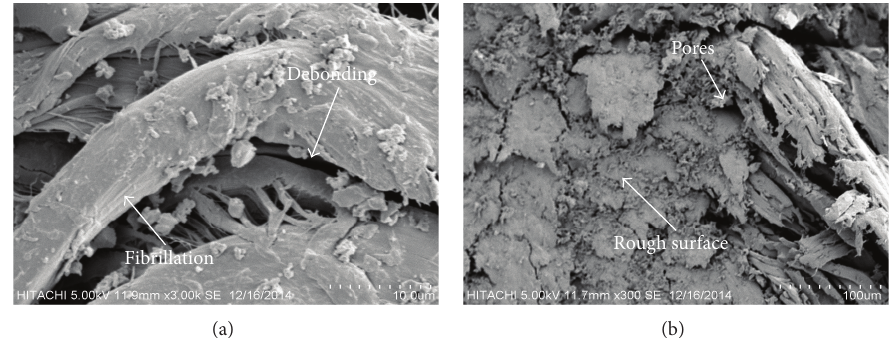
Figure 11: (a) The SEM micrographs of the tensile failure surfaces of KFRV. (b) Bonding area of the woven kenaf with the vinyl ester matrix.